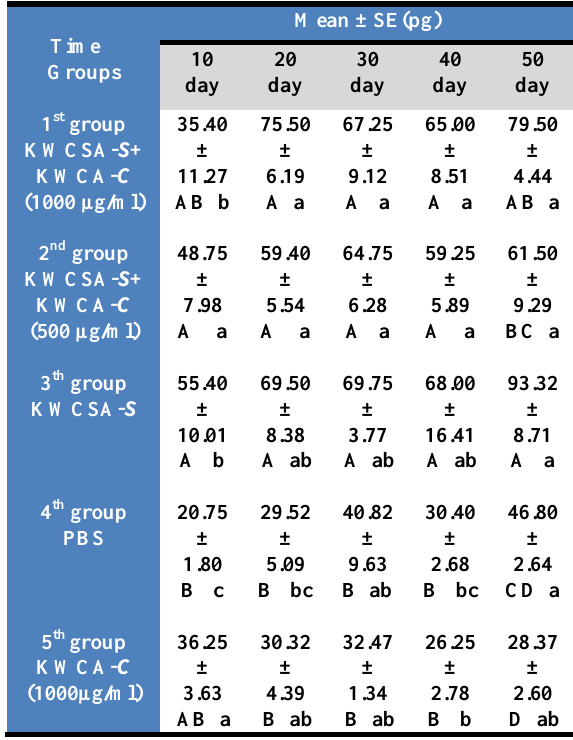
Table, 1: IL-2 concentration (pg) in white rats immunized by whole cell Salmonella enterica subspecies typhimurium and sonicated whole cell Cryptococcus neoformans